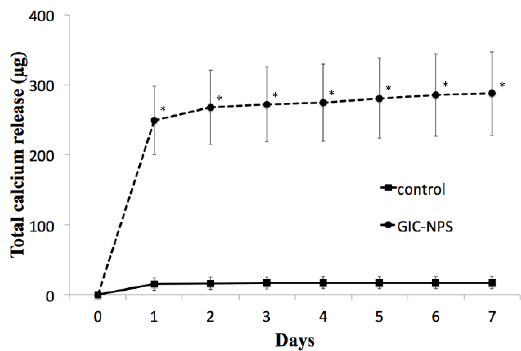
Figure 2. Time-profile of calcium release from the specimens after immersion in 5 wt % calcium chloride solution. Significance was determined using the Mann-Whitney U test ( p < 0.05).